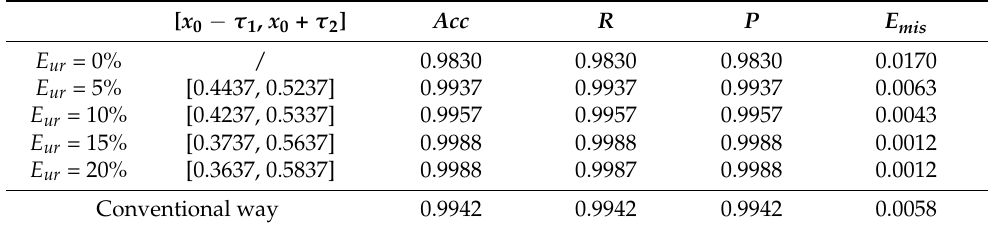
Table 2. Performance of three-way decision in one-dimensional synthetic